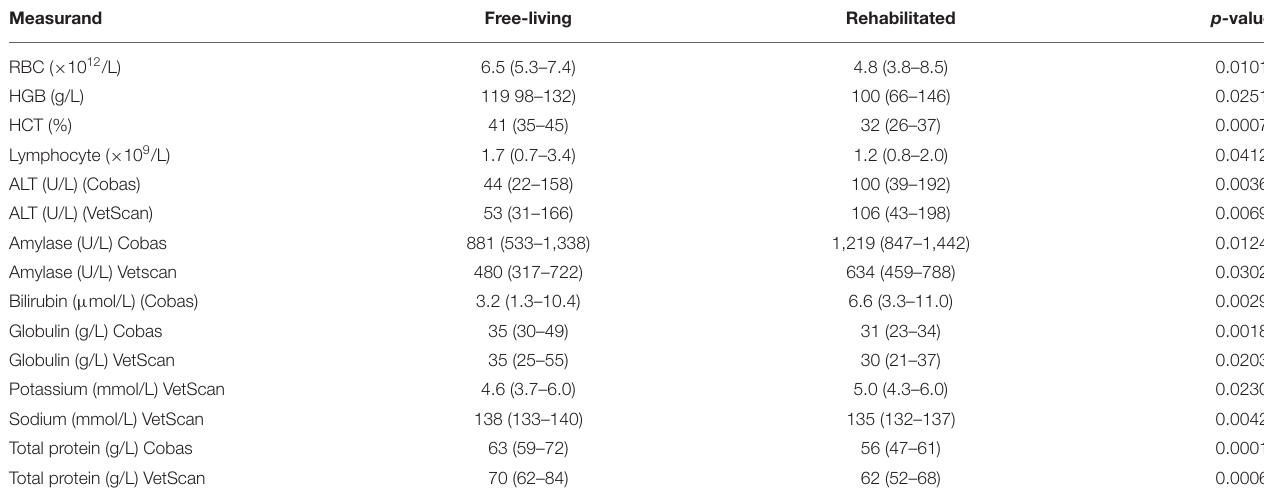
TABLE 5 | Median and range (in parentheses) for measurands that were significantly different between free-living and rehabilitated Temminck’s pangolins. Measurand